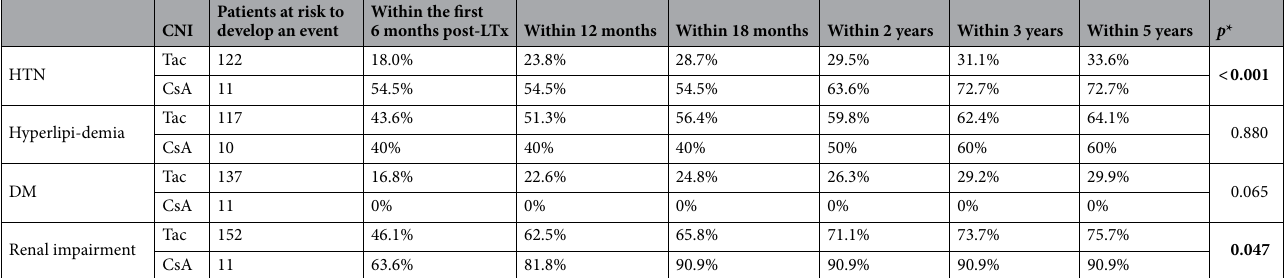
Table 4. Cumulative de novo cardiovascular risk factors and renal impairment in LTRs undertaking CNI treatment. HTN arterial hypertension, CNI calcineurin inhibitor, CsA cyclosporine, DM diabetes mellitus, Tac tacrolimus. *The boldface type indicates differences that are statistically significant ( p <